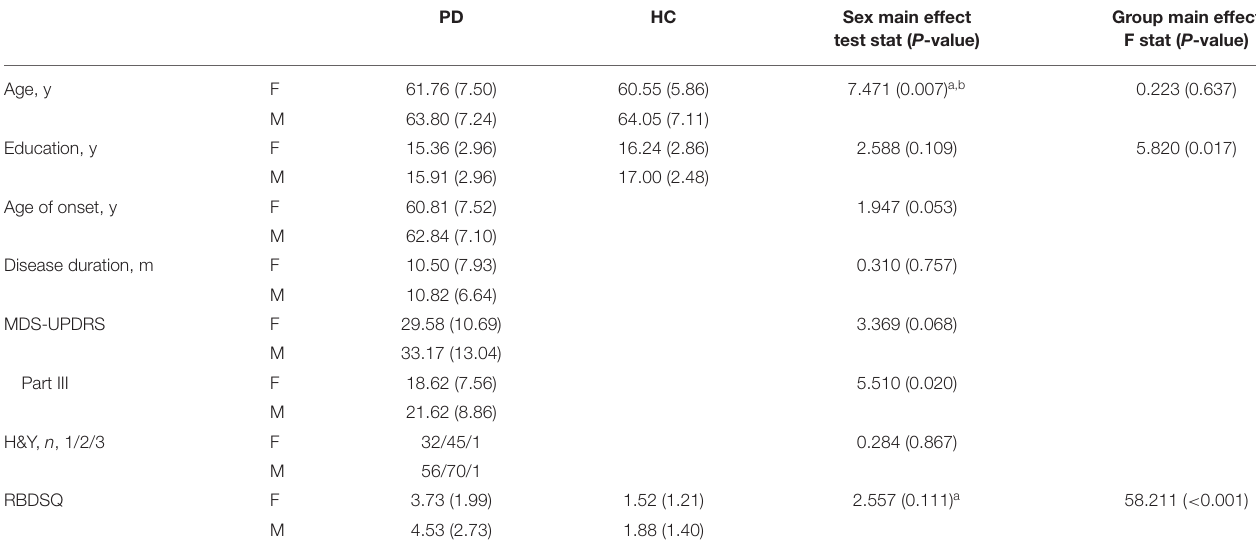
TABLE 1 | Demographic and clinical characteristics of PD and HC females and males. PD HC Sex main effect test stat ( P -value)